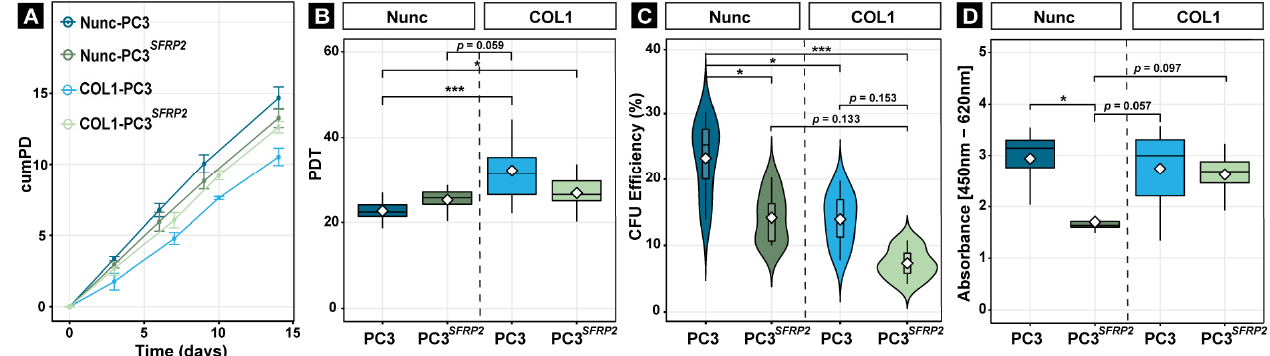
Figure 5. SFRP2 overexpression suppresses the reduced proliferation of PC3 cells on the COL1 surface. Cumulative population doubling ( cumPD ) ( A ) and population doubling time ( PDT ) ( B ) revealed that culturing PC3 cells on a COL1-coated surface reduced their proliferation in comparison to PC3 SFRP2 . COL1, and SFRP2 mutually significantly reduced CFU efficiency of PC3 cells ( C ). Metabolic activity is significantly reduced in PC3 SFRP2 cells on the CCP surface compared to native PC3. However, this significant difference is no longer observed when the cells are cultured on COL1 surface ( D ). Significance levels: * equals p ≤ 0.05; *** equals p ≤ 0.001.